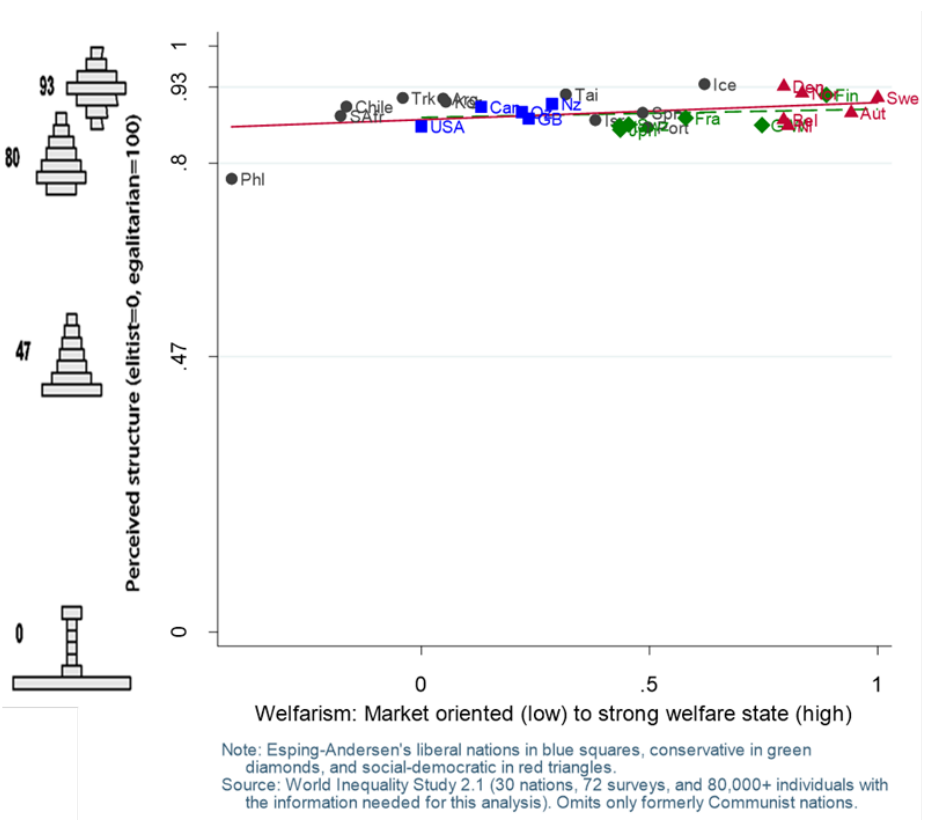
Figure 8. How much inequality OUGHT we have? County means and OLS fit lines (welfarism scale: solid red. Esping-Andersen: dashed green).